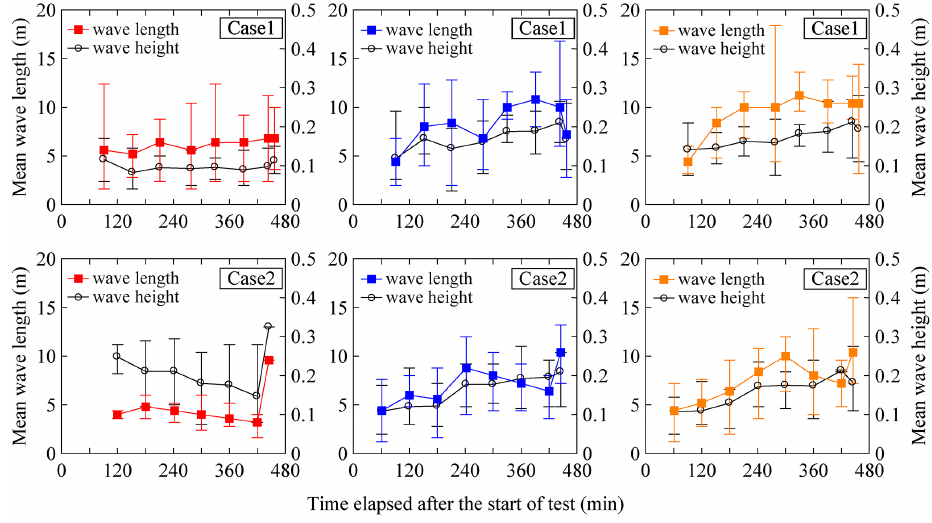
Fig. 4. Time history of sand wave configuration Top: Case 1, bottom: Case 2. Left: line L, centre: line C, right: line R.